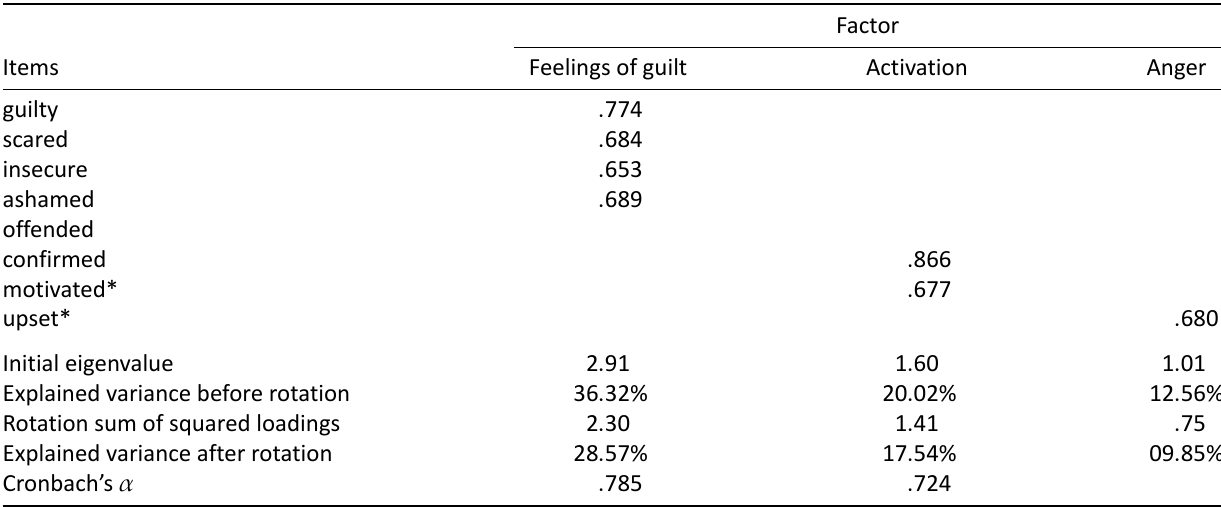
Table 2. Principle axis factoring of affect